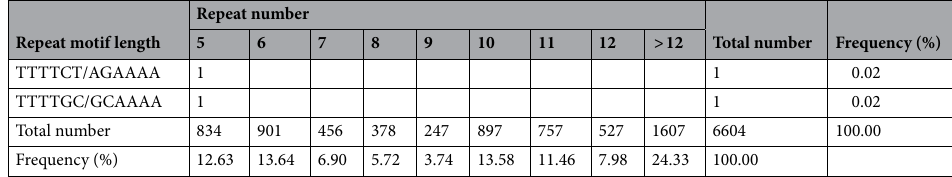
Table 3. The six types of SSR repeat motifs and their frequency in P. catalpifolia.